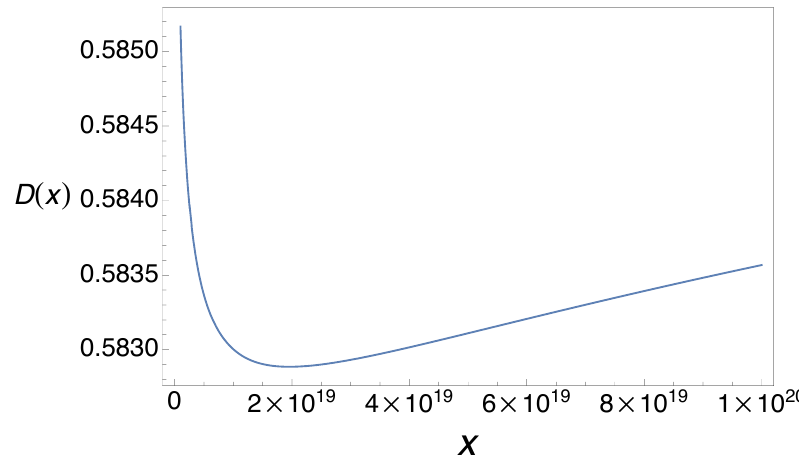
Figure 6. We plot D ( x ) at λ = 1 / 15 and T = 1 / 12 without the non-perturbative branch. We see the turning point is at x ∼ 2 × 10 19 .